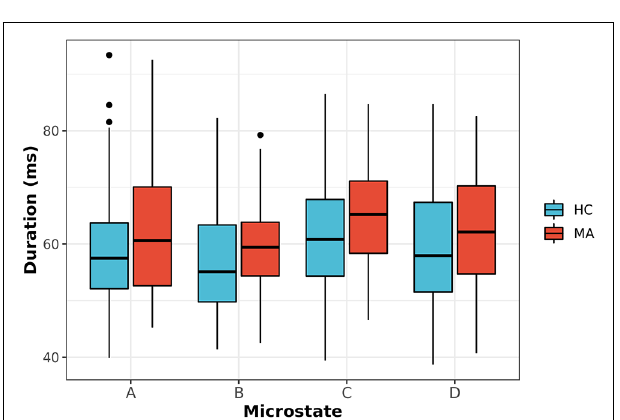
FIGURE 2 | The average duration for EEG-ms classes (A–D) for MA and HC groups ( p -value corrected for multiple comparisons using the Bonferroni -Holm). The results revealed a trend towards significance for microstate C with p = 0.092.